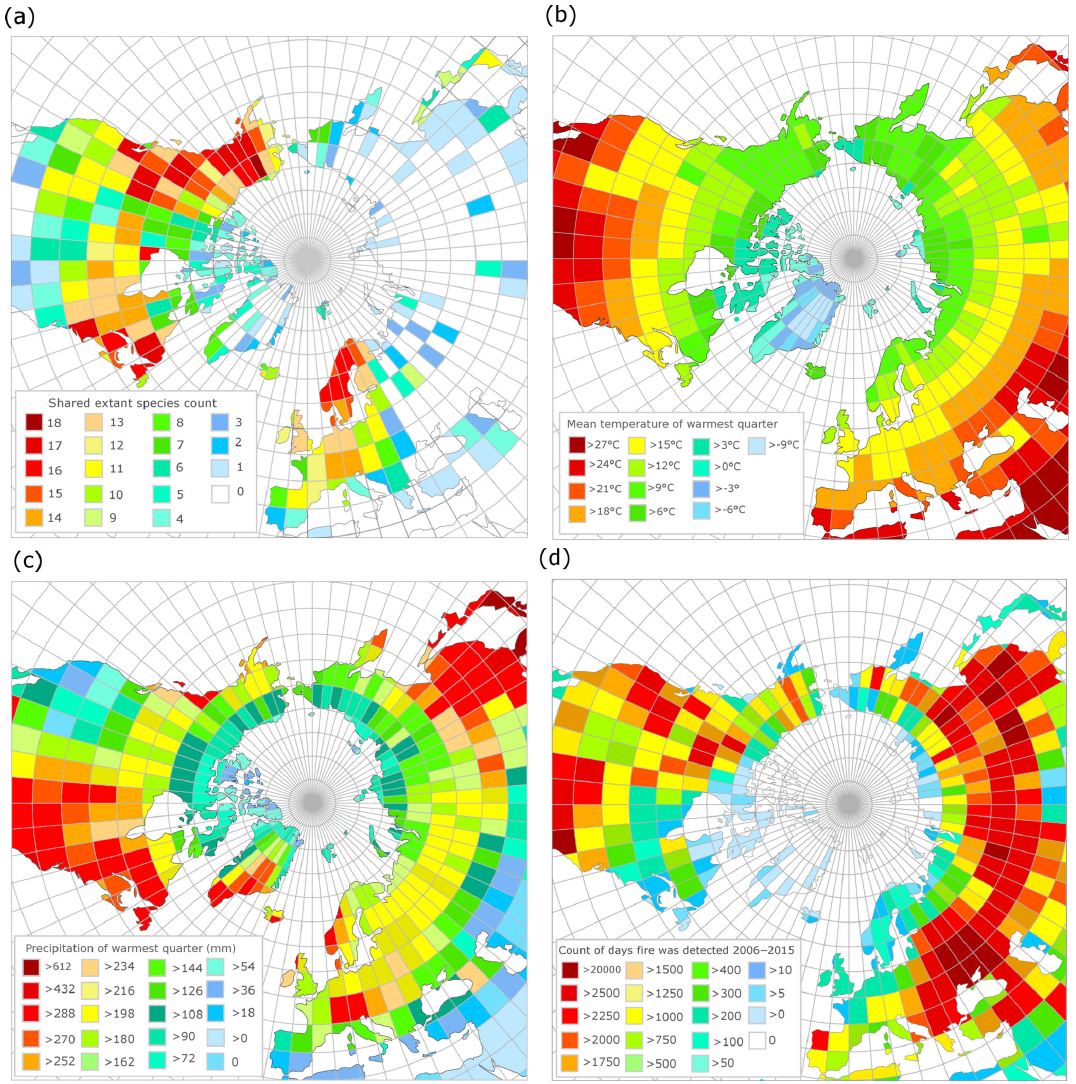
Figure 7. (a) Modern geographic distribution of observed occurrences of species common to the Beaver Pond species list. (b) Mean tem- perature of the warmest quarter (summer average) derived from WorldClim. (c) Mean precipitation of the warmest quarter (summer rain) derived from WorldClim. (d) Count of unique fire pixels detected per day over 10 years from MODIS 6 fire product, normalized by area of the latitude by longitude